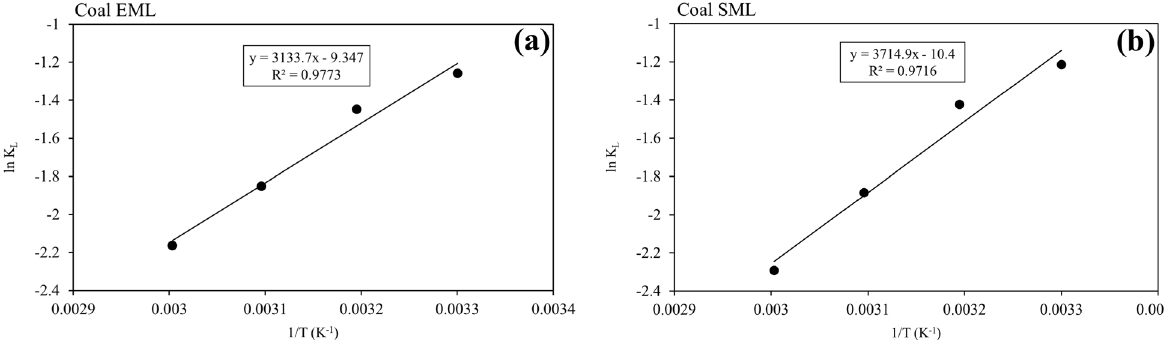
Fig. 12 van’t Hoff plots for a Coal EML and b Coal